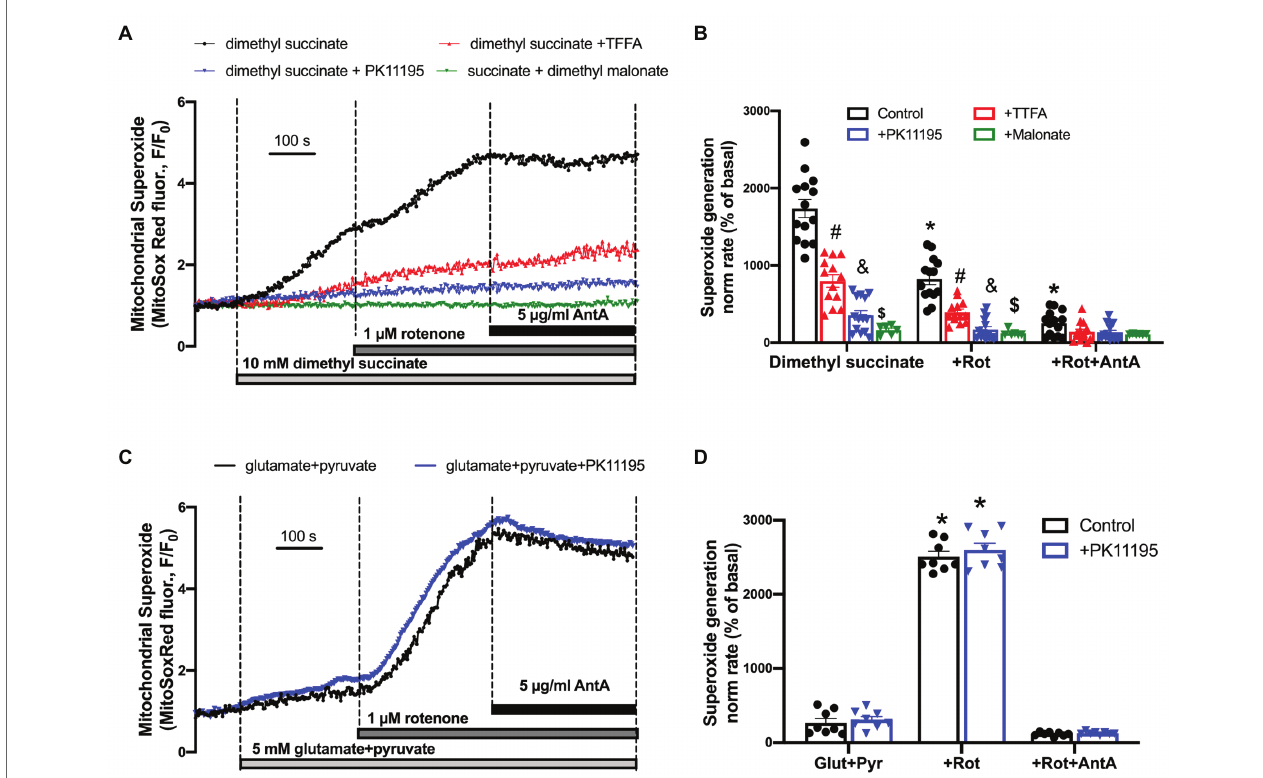
FIGURE 8 | Succinate-mediated ROS generation in control ventricular rabbit cardiomyocytes. (A) Shown are representative traces of mitochondrial superoxide generation measured from control rabbit myocytes exposed to 10 mM cell-permeable dimethyl succinate (black trace) and myocytes treated with 100 μ M TTFA (red trace), 50 μ M PK11195 (blue trace), and 10 mM dimethyl malonate (green trace). About 1 μ M rotenone and 5 μ g/ μ l antimycin A (AntA) were added sequentially in each experiment to block mitochondrial complex I and complex III, respectively. (B) Summary bars reflect that superoxide generation induced by dimethyl succinate was only partially affected by complex I inhibitor rotenone, and almost completely blocked by complex III inhibitor AntA indicating the forward mode of superoxide production. PK11195 was more effective in blocking mitochondrial superoxide generation compared to complex II inhibitor, TTFA but less effective than dimethyl malonate. Data expressed as mean ± SEM. n = number of cells from three different animals per each group. (C) Changes in mitochondrial superoxide production upon complex I stimulation with 5 mM glutamate in combination with 5 M pyruvate, and subsequent exposure to 1 μ M rotenone and 5 μ g/ μ l AntA. (D) Summary